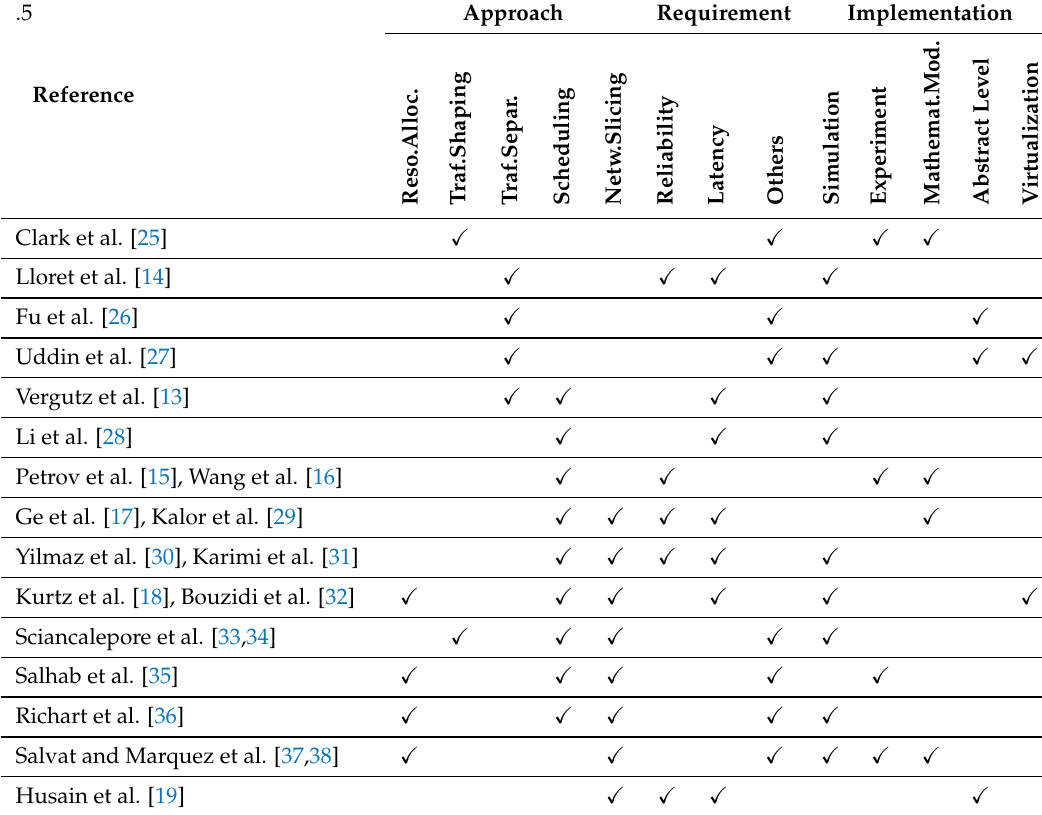
Table 1. Main works of Network Performance